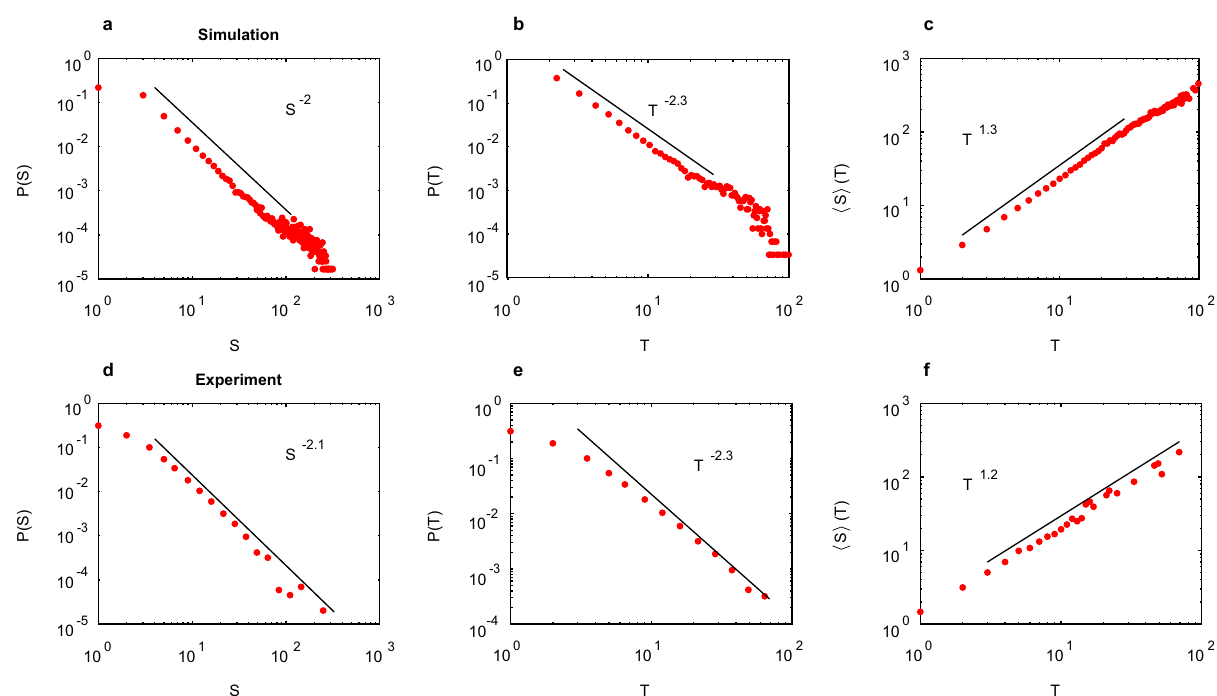
Fig. 4 Avalanche statistics of simulated and experimental networks. Top row — probability distributions of avalanche size S ( a ) and life-time T ( b ) and plot of average size as function of life-time ( c ) for simulated networks. Bottom row — probability distributions of avalanche size S ( d ) and life-time T ( e ) and plot of average size as function of life-time ( f ) for experimental networks. Statistics are produced from simulations on an ensemble of 1000 independently generated networks stimulated at V * = 1. Simulations used networks with 2250 nanowires and 6800 – 7100 junctions (size 150 × 150 μ m 2 and density 0.10 nw ( μ m) − 2 ). Experiments are at the same density and have size 500 × 500 μ m 2 . Maximum likelihood power-law fi ts are indicated.